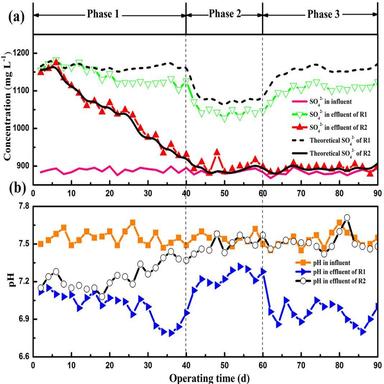
The sulfate concentration and theoretical sulfate production (a), pH variations (b) of influent and effluent.